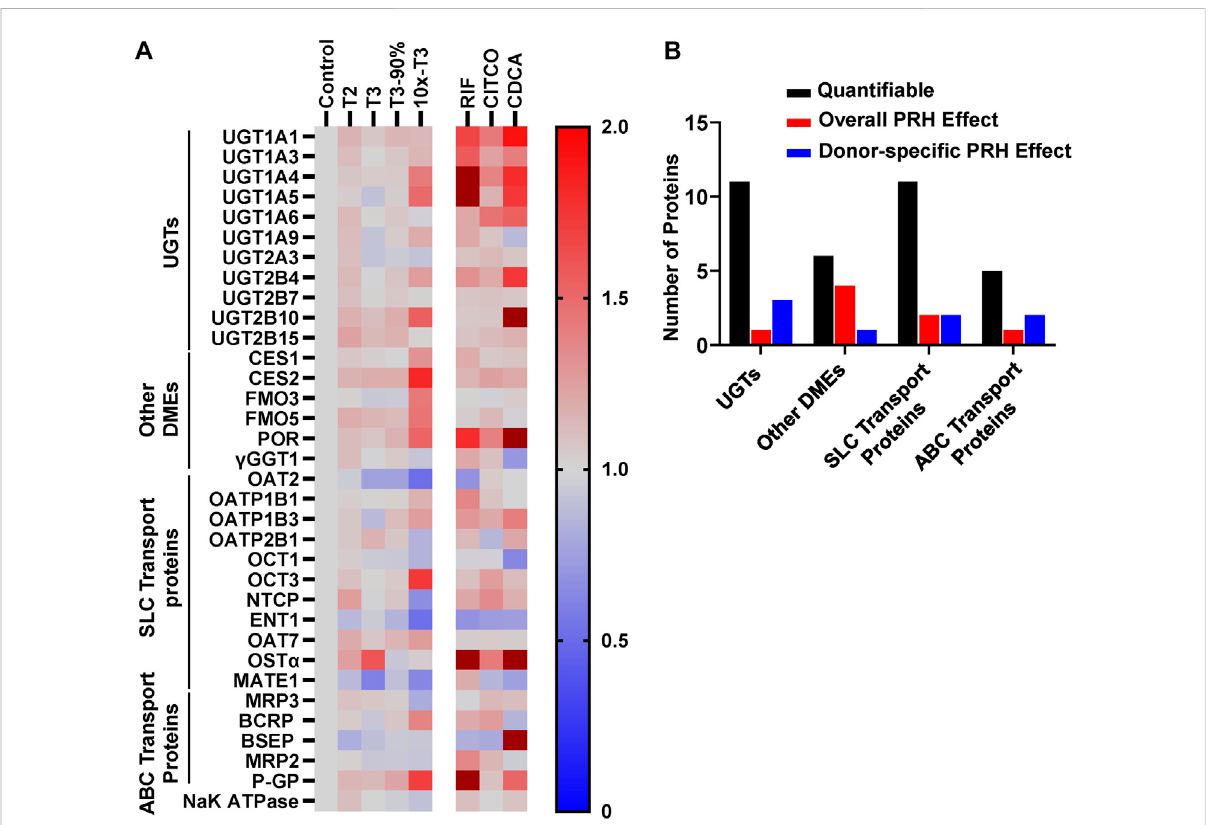
FIGURE 3 PRHs altered the absolute protein concentration of DMEs and transport proteins in SCHH in an isoform and concentration dependent manner. SCHH from fi ve quali fi ed donors were exposed to vehicle control, PRH cocktails, or nuclear receptor activators. The PRH cocktails target average trimester 2 (T2), average trimester 3 (T3), upper range of T3 (T3-90%), and supraphysiological (10xT3) PRH concentrations (Table 1). The experiment in each hepatocyte donor included three to four biological replicates, and mean fold-change was calculated for each protein relative to the vehicle control group within each donor. (A) Heat map summarizing the mean increase, no change, or decrease in concentrations of 33 DMEs and transport proteins across donors relative to the vehicle control group. The impact of RIF, CITCO, and CDCA are presented on the right side of the heat map for comparative purposes. Color index : Deep red (fc > 2) Red (fc > 1), Gray, (fc = 1), and blue (fc < 1). (B) Summary of the number of quanti fi ableproteins(byproteintype)thatexhibitedasigni fi cantnetalterationbyPRH(ANOVA p < 0.05foroverallfold-changeacrossall fi vedonors) or exhibited a donor-speci fi c alteration by PRH (ANOVA p < 0.05 within two or more donors, but ANOVA p > 0.05 for overall fold-change across all fi ve